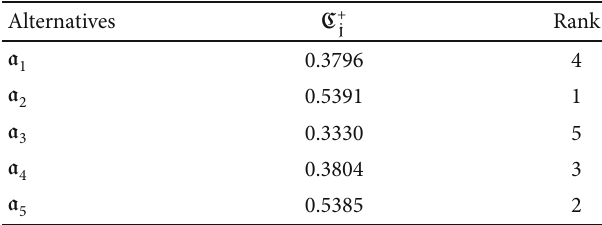
Table 10: SLDF closeness coe ffi cient of each